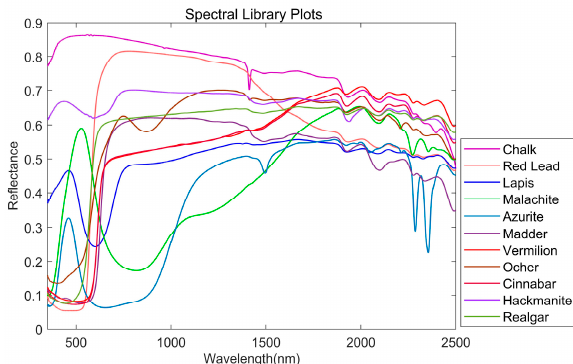
Figure 4. Some spectra in the typical pigment spectral library.